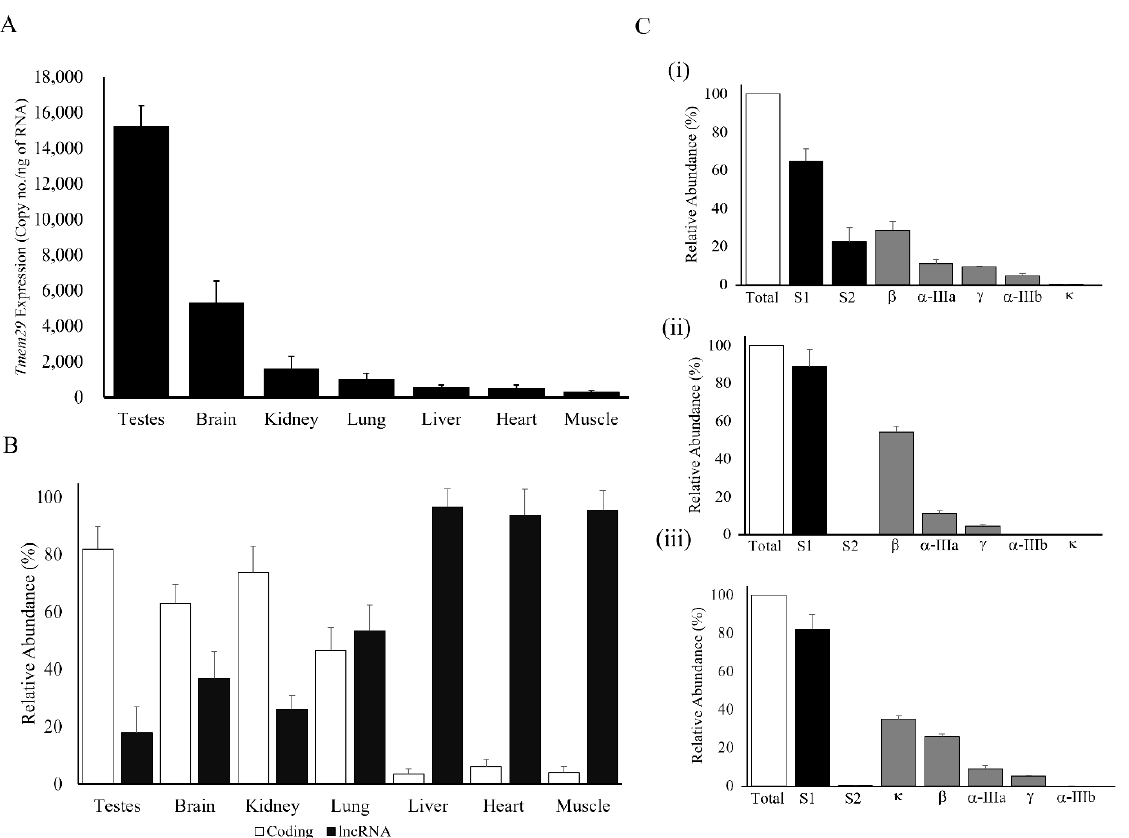
Figure 2. Expression profiling of Tmem29 in different mice organs by Taqman absolute quantification PCR. ( A ) Quantification of Tmem29 transcripts in different adult wild-type mice organs; ( B ) Relative coding and lncRNA expression in different mice organs. Individual subgroup (S1, S2) and different splice variants’ relative abundance was referenced to total Tmem29 mRNA and expressed in percentage. Relative abundance measurement of protein-coding transcripts in mice (i) brain, (ii) kidney, and (iii) testes; ( C ) Relative abundance measurement of protein-coding transcripts in mice (i) brain, (ii) kidney, and (iii) testes. Data were expressed in mean ± standard deviation with 6 individual mice, and experiments were done in triplicate.